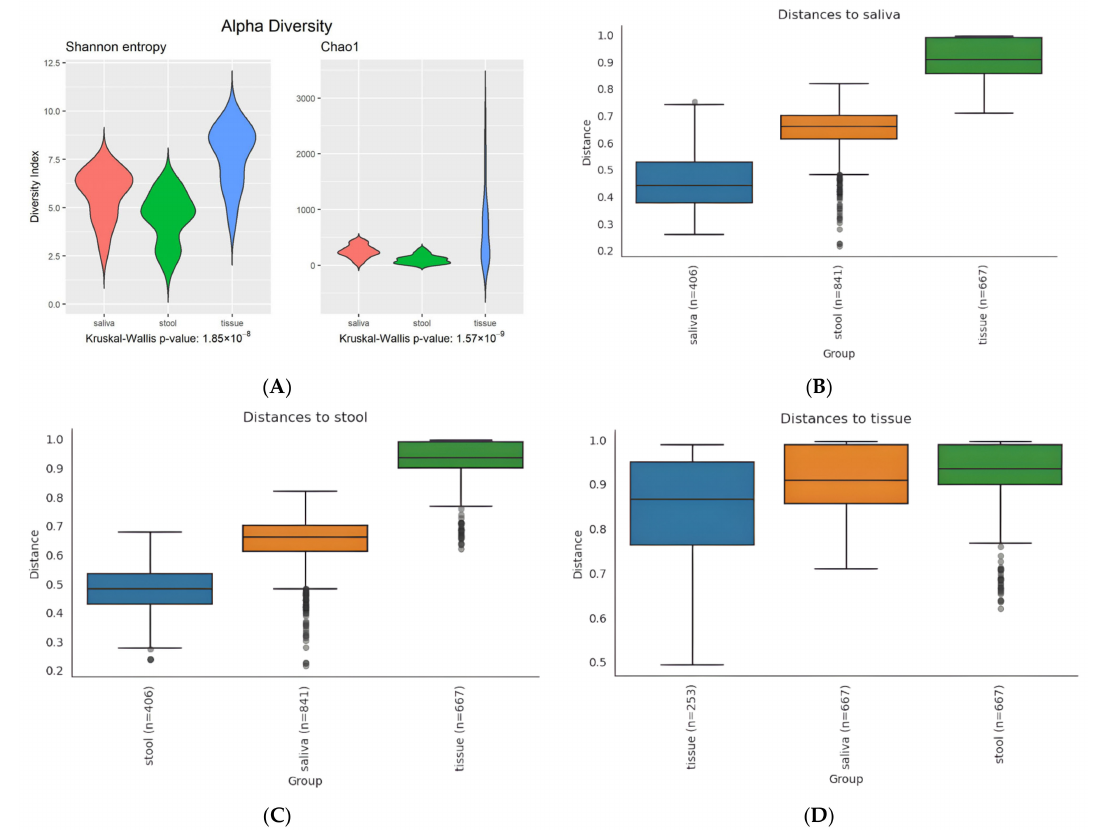
Figure 1. Diversity in microbiota. Alpha diversity of the microbiome in saliva, tissue, and stool samples of patients with CD ( A ). Beta diversity; unweighted UniFrac distance to saliva ( B ), stool ( C ), and tissue ( D ) of microbiome in the saliva, tissue, and stool of CD patients. Unweighted UniFrac distance incorporates distances in the phylogenic tree among members in comparing groups. n, match count for each cases; the saliva (29)–stool (29) pair has 841 (=29 × 29) matches, and tissue (23)–saliva or –stool (29) have 667 (=23 × 29). Cases within groups are 406 (=29C2) for saliva or stool and 253 (=23C2) for tissue. PERMANOVA resulted in a p -value of 0.001 (<0.05) for all three pair cases, indicating each pairwise cases have statistically significant difference.